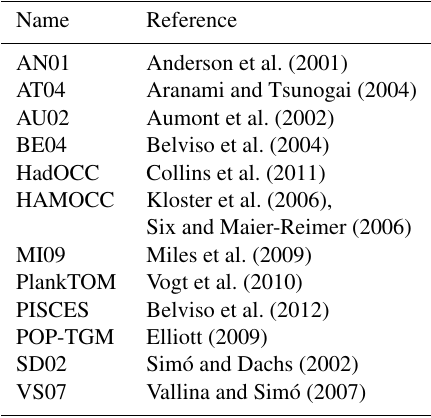
Table 4. Diagnostic and prognostic models used to estimate DMS concentrations in Fig. 6. These models are discussed in detail in Tesdal et al.